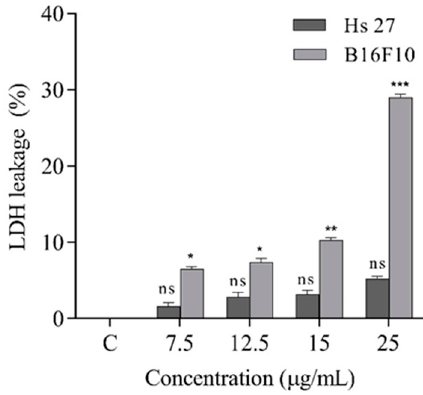
Figure 5. Effects of treatment on the lactate dehydrogenase (LDH) release in both cell lines after 24 h of exposure to treatment. Data represent the means ± SEM of at least three independent experiments (significant differences, * p < 0.05, ** p < 0.01, *** p < 0.001, n.s. no significant differences).